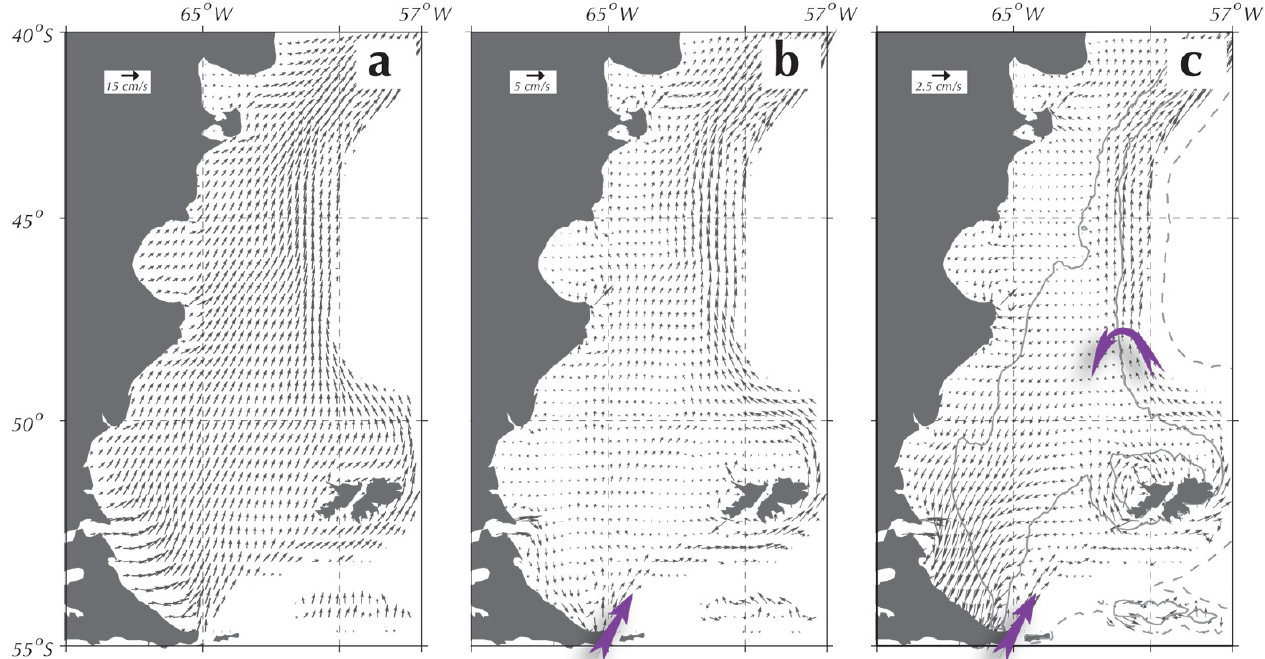
Fig. 7. Time averaged velocities at the upper, intermediate, and bottom levels of EXP1. The purple arrows mark the regions of largest cross-shelf